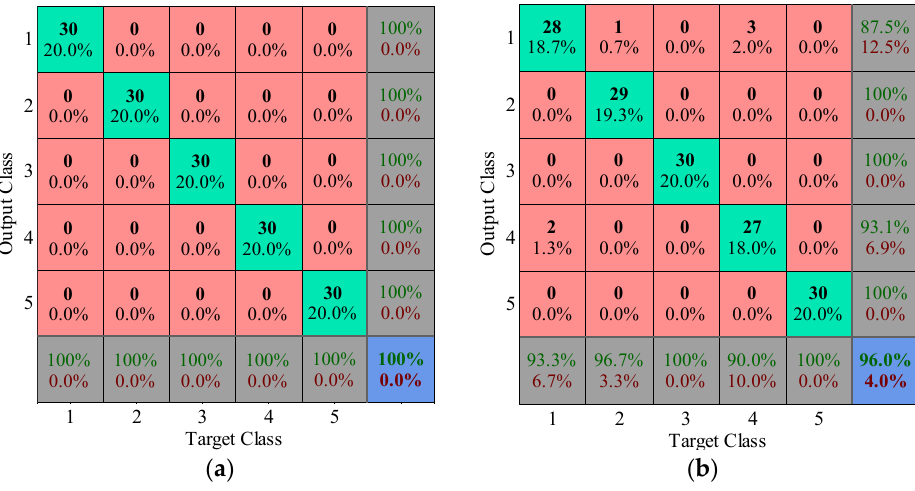
Figure 17. Multi-class confusion matrices of testing samples: ( a ) Dictionary learning pre-processor; ( b ) EMD pre-processor.